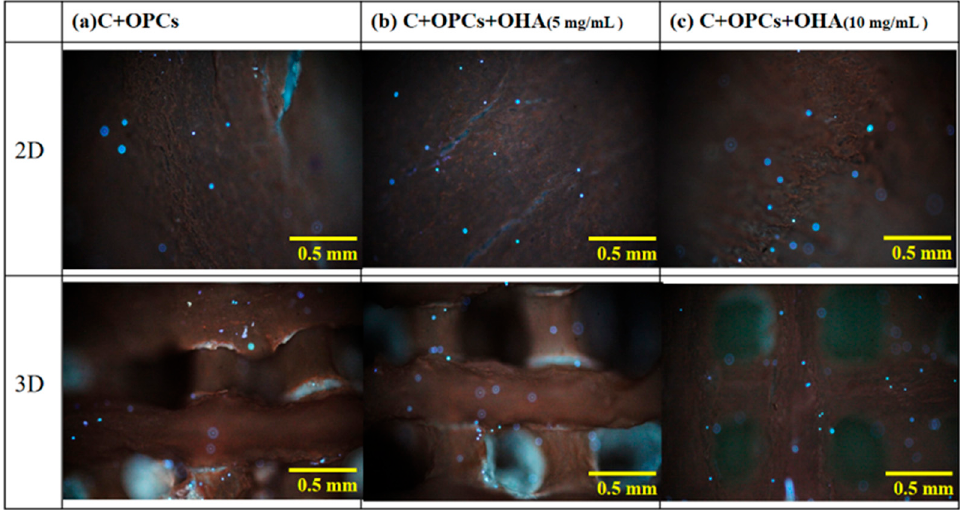
Figure 10. Fluorescence images of rat bone marrow mesenchymal stem cells on a 2D membrane and 3D scaffolds with different compositions and concentrations. Each fluorescence spot represents a stained stem cell nucleus.